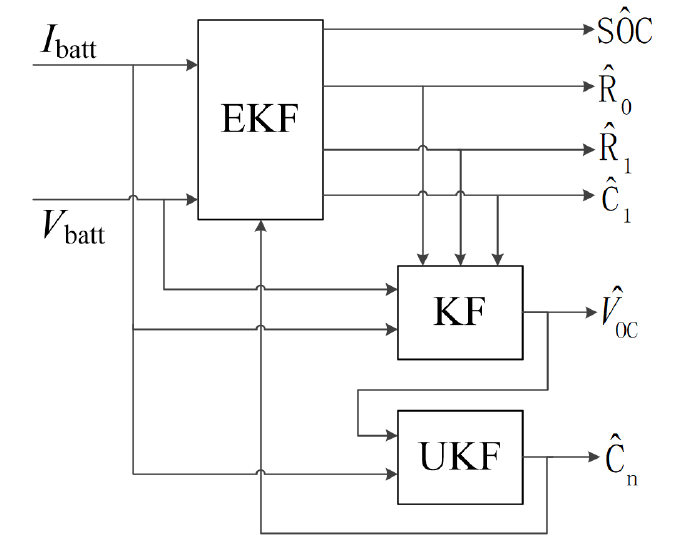
Figure 7. New proposed